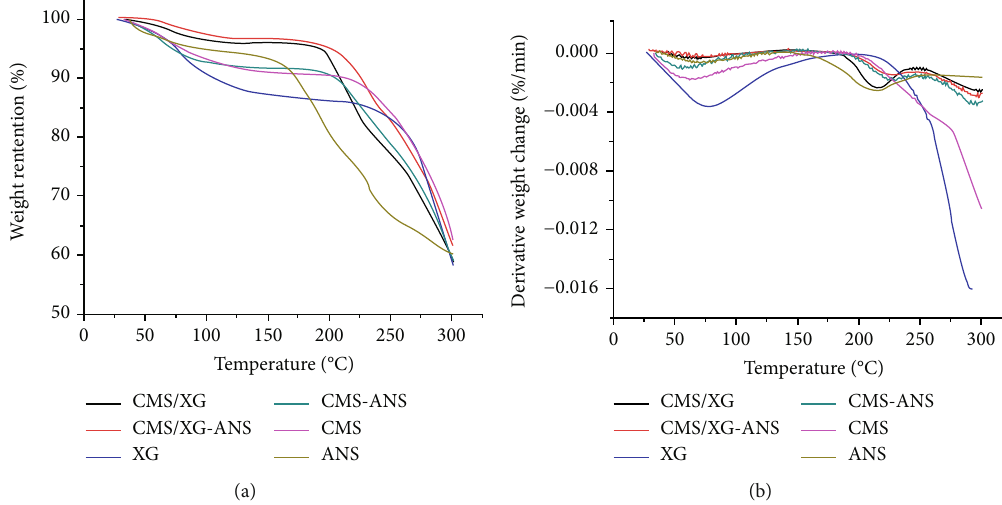
Figure 7: In vitro release kinetics of anthocyanins from (a) CMS-ANS, (b) CMS/XG(150/1)-ANS, (c) CMS/XG(120/1)-ANS, (d) CMS/ XG(90/1)-ANS, (e) CMS/XG(60/1)-ANS, and (f) CMS/XG(30/1)-ANS under stimulated gastric (a) and intestinal (b) conditions